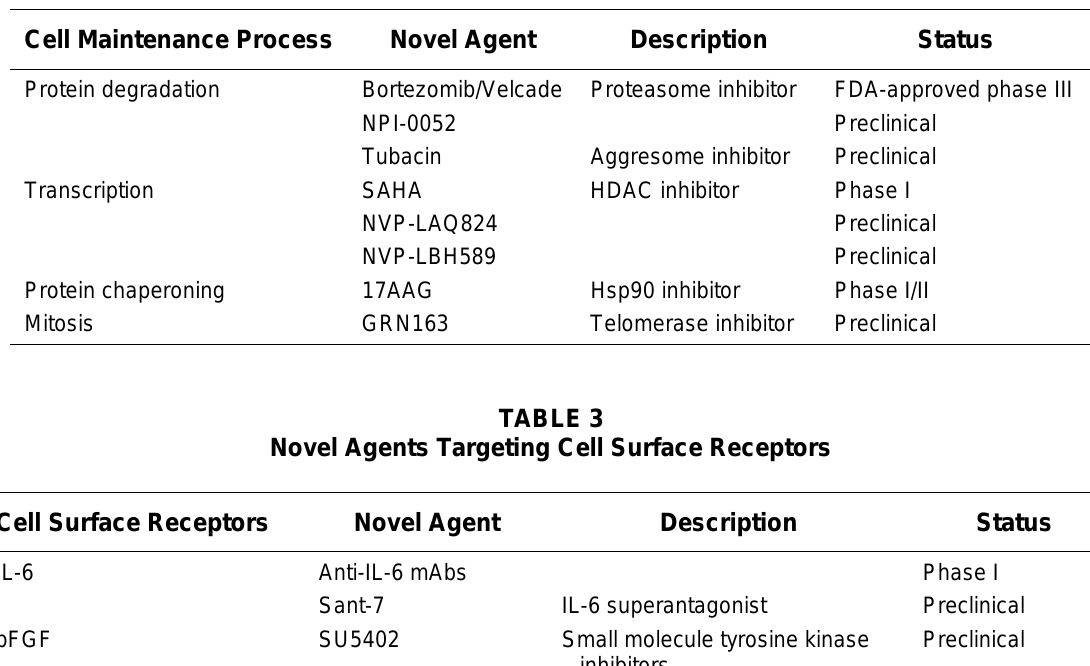
Novel Agents Targeting Cell Maintenance